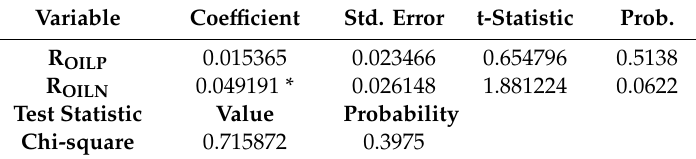
Table 23. Regression results for positive and negative oil price changes.